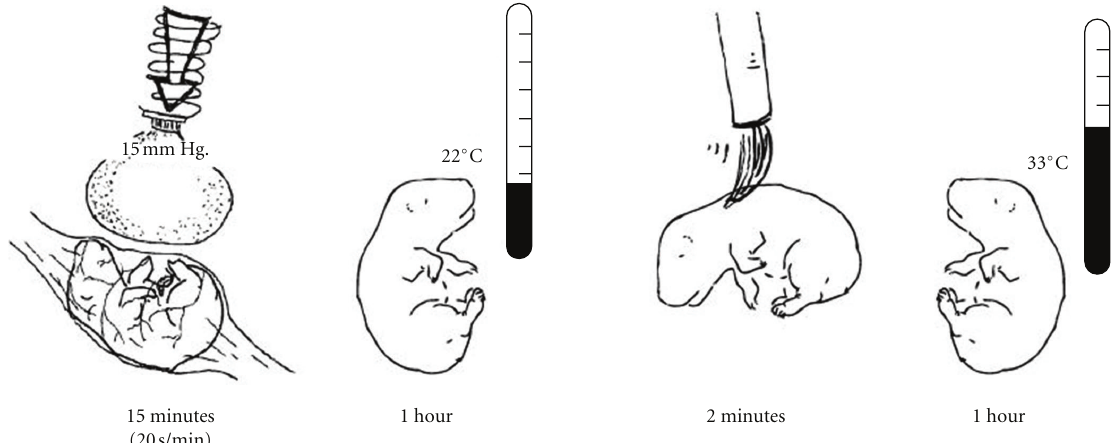
Figure 3: Four stages in a protocol for simulating a vaginal birth sequence. The drawings depict, from left to right: Simulated contractions delivered 15 times to a fetus still in utero but externalized from the dam’s abdomen, once per minute for 20 sec each from a balloon attached to a calibrated (15 mmHg) spring-loaded device; one hour of cooling after caesarian delivery, simulating a typical challenge faced by pups lying in the vicinity of their parturient dam still busy delivering other pups; two minutes of stroking with a soft brush, mimicking the postpartum licking by the dam; one hour of rewarming, simulating the heat received from the dam’s body after being gathered and assembled in a nest with newborn littermates.